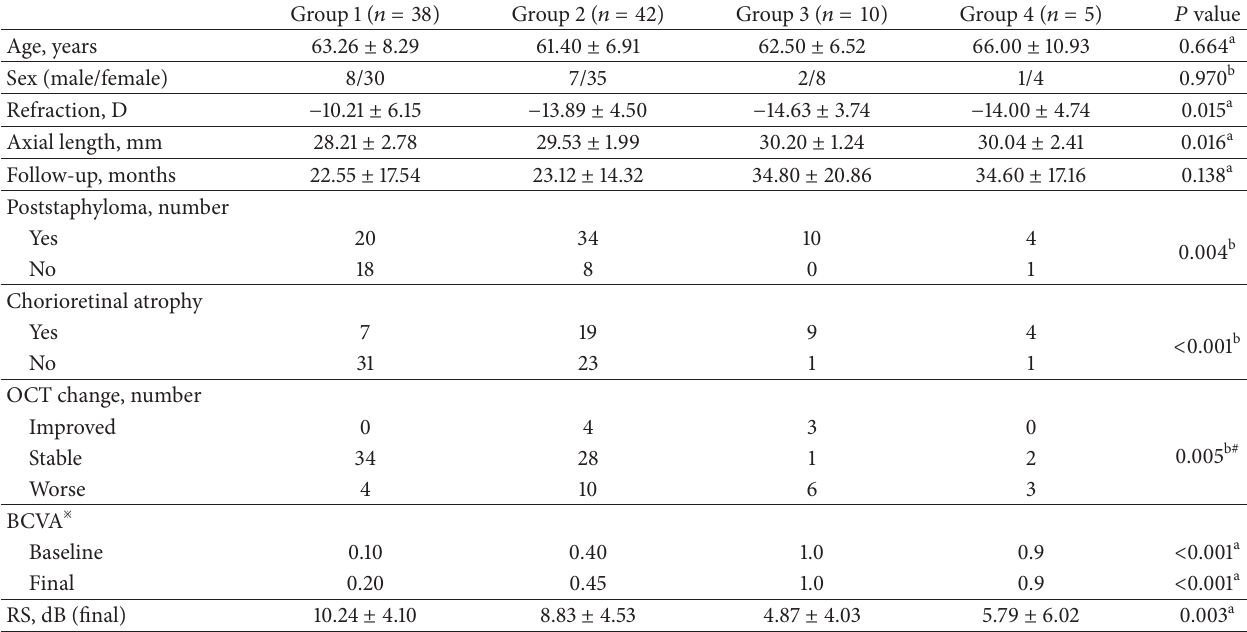
Table 2: Fellow eye characteristics in patients with MTM